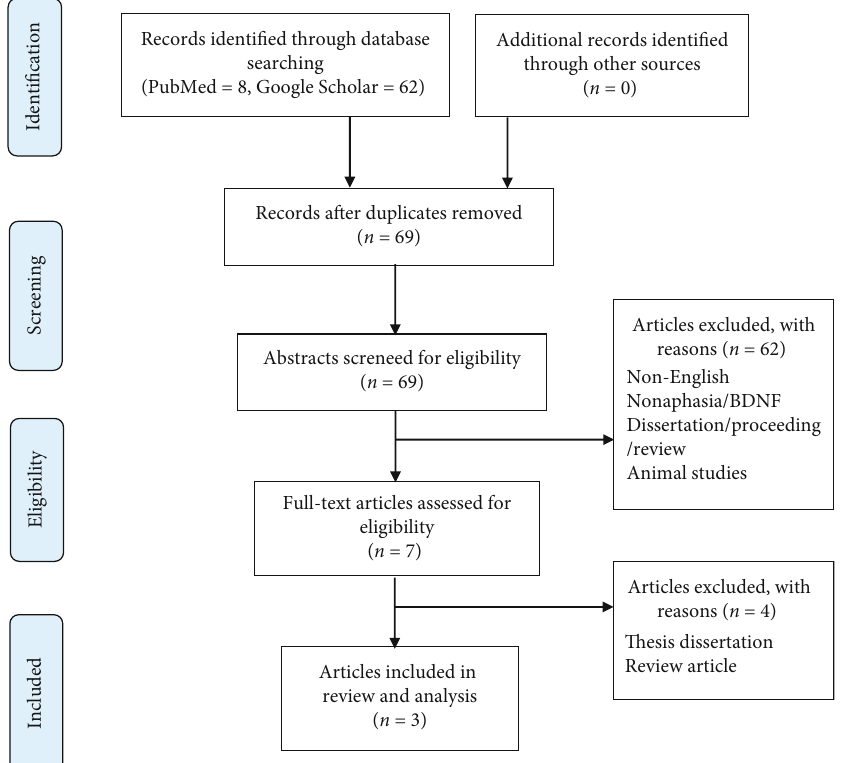
Figure 1: PRISM fl owchart of the article selection